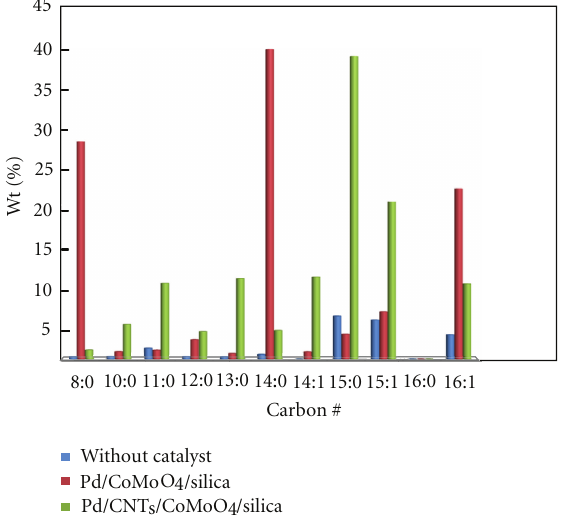
Figure 5: Hydrocracking performance of Pd/CoMoO 4 /silica and Pd/CNTs/CoMoO 4 /silica: C8–C16 fraction before and after hydro- cracking. C n :0 indicates saturated hydrocarbons, and C n :1 for the unsaturated ones.